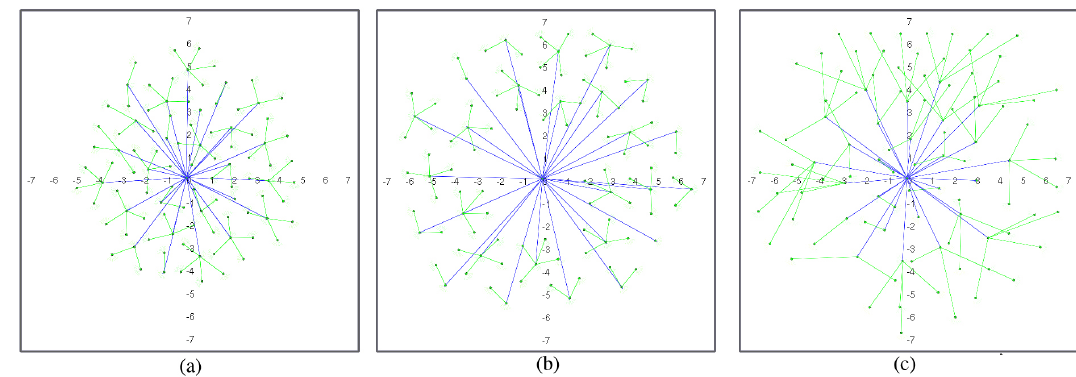
Figure 4. Hierarchical MWSN: ( a ) with all clustering forces; ( b ) without clustering force L1 vs. the sink node (L2); ( c ) without clustering force L0 vs. L1 (figures are scaled 1:10